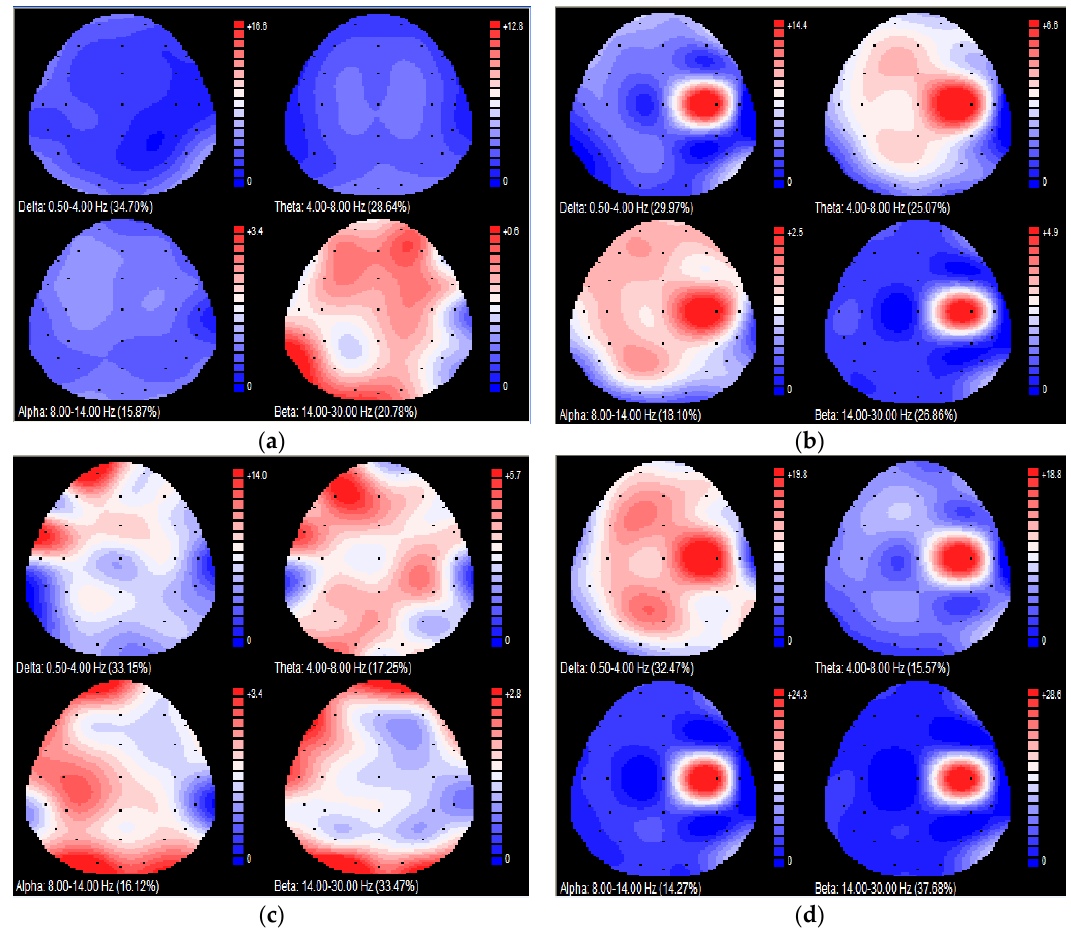
Figure 4. Relative energy spectrum of δ, θ, α and β at four different anger levels from one subject. ( a ) Anger level = 0 (Neutral); ( b ) Anger level = 1; ( c ) Anger level = 3; ( d ) Anger level = 5. Table 1. Statistical (mean (std.)) and significance analysis of EEG spectral features between different anger intensity from all subjects. (The bold face number means the differences are significant.)